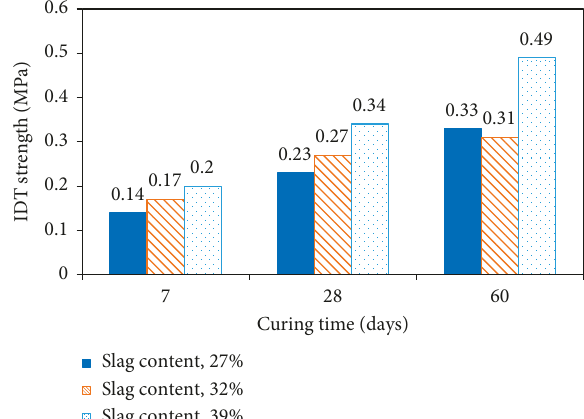
Figure 12: IDT strength results for CTB.